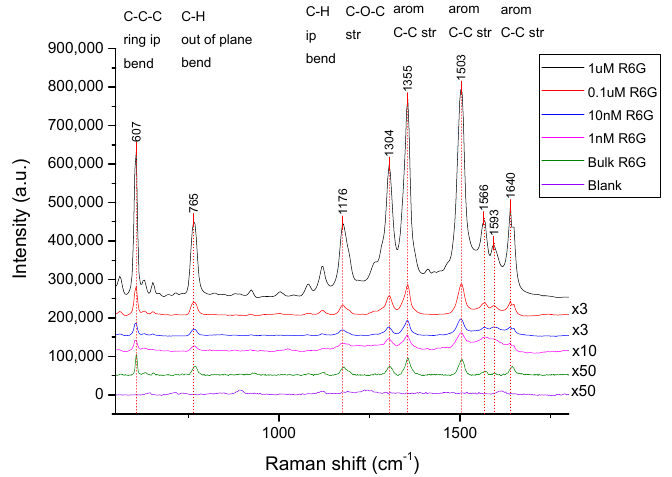
Figure 9. The SERS spectra of blank SERS substrate, bulk R6G, and various concentrations of R6G solution (1 × 10 − 6 M, 1 × 10 − 7 M, 1 × 10 − 8 M, and 1 × 10 − 9 M, respectively) with our SERS substrates. The Raman band assignment of the main peaks of R6G is given in the figure.